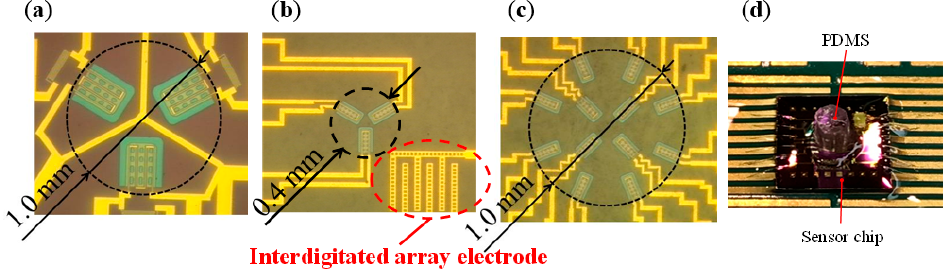
Figure 5. Optical microscopic images of ( a ) conventional sensor, ( b ) newly fabricated sensor of Type A, and ( c ) newly fabricated sensor of Type B, and ( d ) the sensor chip with PDMS.